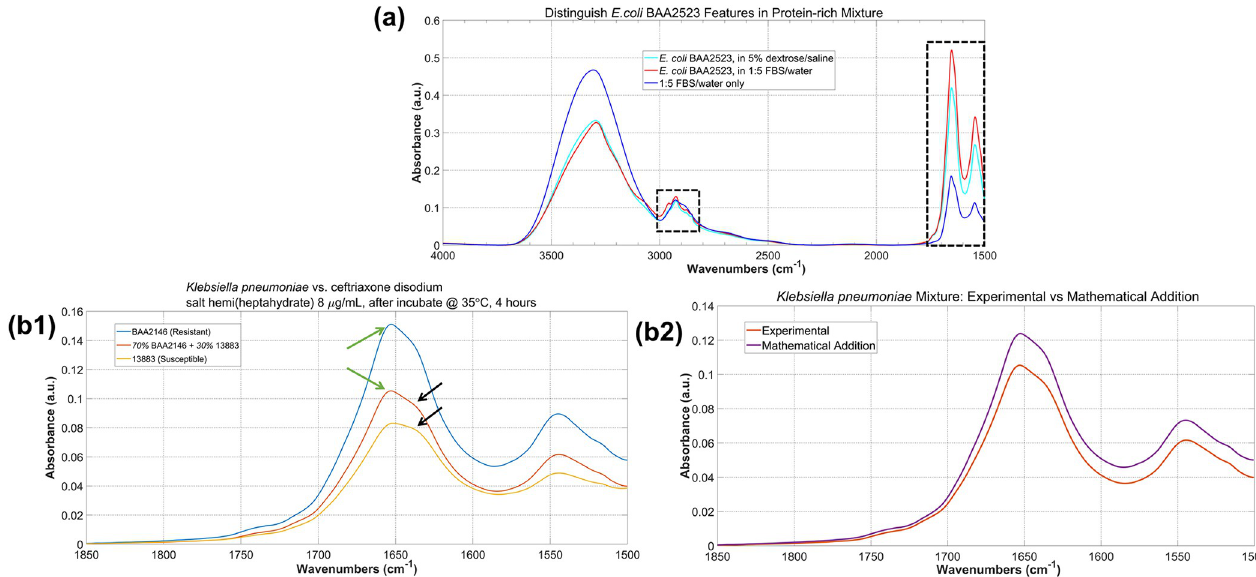
Fig 3. Selectivity of the ATR system. (a) averaged ATR spectra of E . coli BAA2523 in (cyan) 5% dextrose saline and in (red) FBS/water 1:5 mixture. The spectra of the FBS/water 1:5 mixture itself is shown in Blue. The two black rectangular boxes highlight two spectral regions where clear spectral differences can be seen. (b1) ATR spectra of K . pneumoniae BAA2146 (MDR), K . pneumoniae 13883 (susceptible) and a mixture of 60% BAA2146 and 40% 13883. Zoom-in view to the Amide I–Amide II spectral region (1500–1850 cm -1 ). # of viable cells in all three are in the 10 7 cfu/mL range. (b2) Contributions from BAA2146 and 13883 are clear in the mixture spectrum, marked by similarity between the experimental spectrum and the mathematical addition of the BAA2146 and 13883.